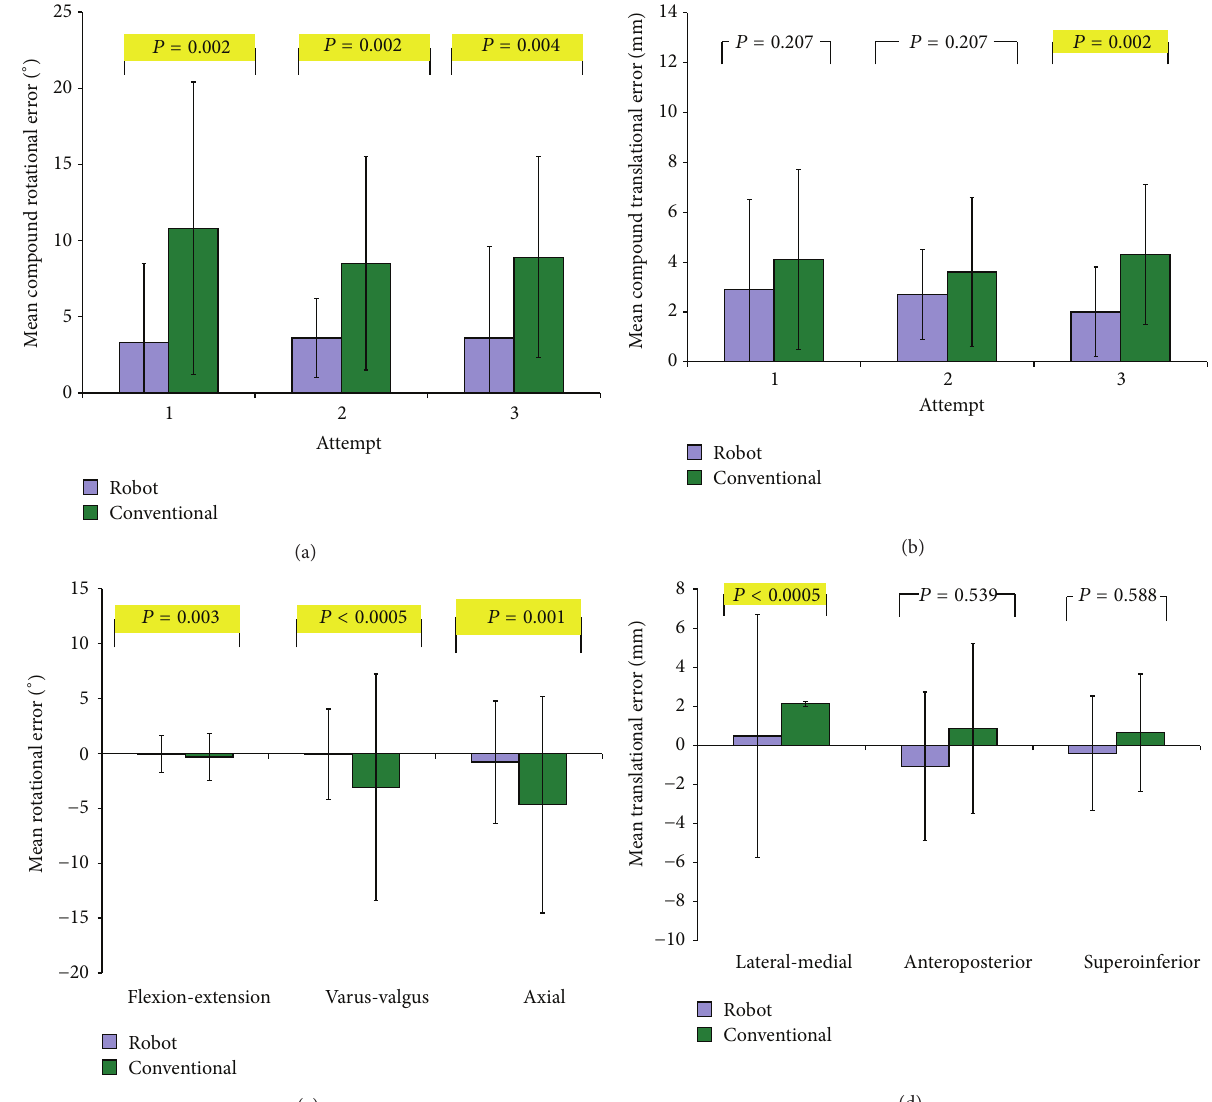
Figure2:Bargraphscomparingfemoralcomponentinrobotandconventionalgroupsatattempts1,2,and3bymean(a)compoundrotational error, (b) compound translational error, (c) rotational alignment in each DoF, and (d) translational alignment in each DoF. 𝑃 values compare mean root mean squared errors between